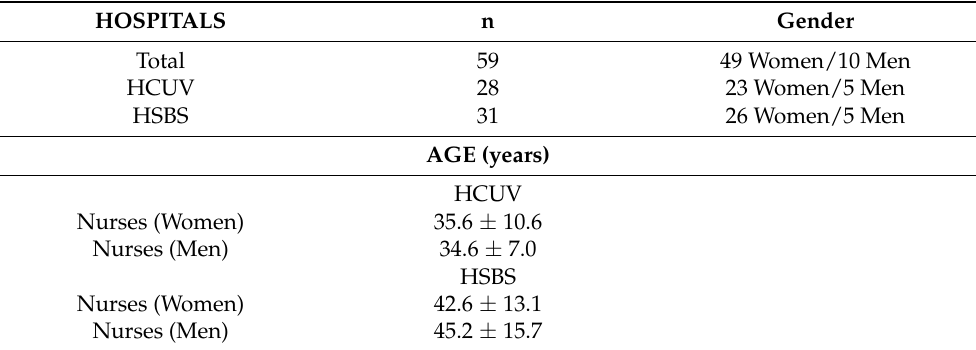
Table 1. Demographic data of the nurses participating in the study.